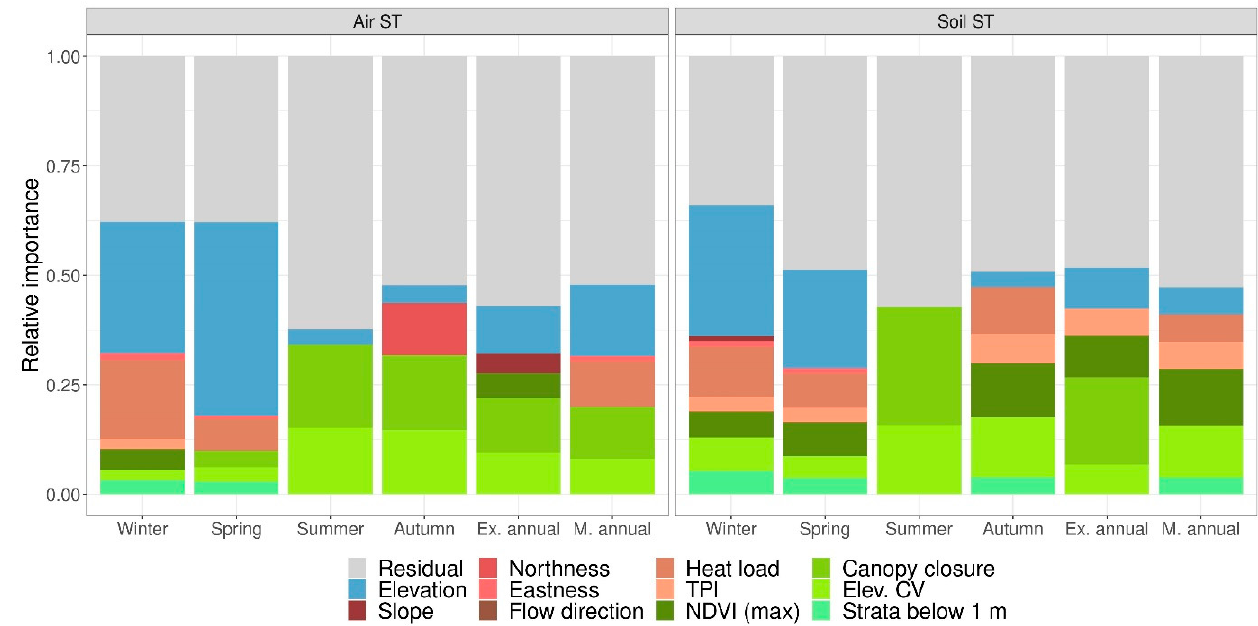
Figure 10. Relative importance of explanatory variables for modeling stability (Tx-Tn) from records taken by in situ sensors in the air and on the ground over the 2100 m altitude of the PNOMP. The columns correspond to one of the six models: the four seasons, the annual extreme (Ex. annual: Tx of the hottest month, Tn of the coldest month), and the annual mean (M. annual: average of the 12 monthly stabilities).